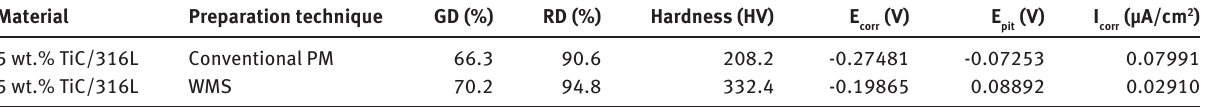
Table 1 Effect of preparation technique on the densification and electrochemical response of composites. GD, green density; RD, relative density.